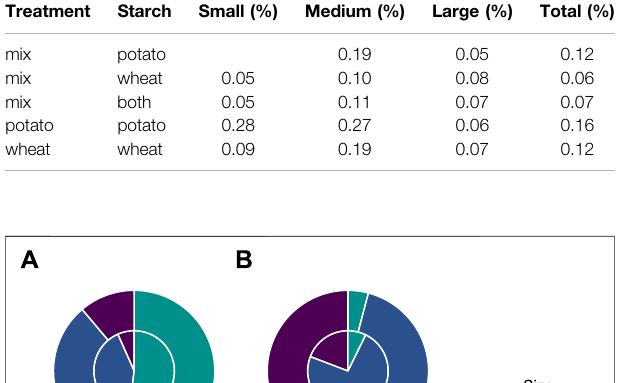
TABLE 4 | The mean percentage of starches from the solutions that were incorporated into the samples. Treatment